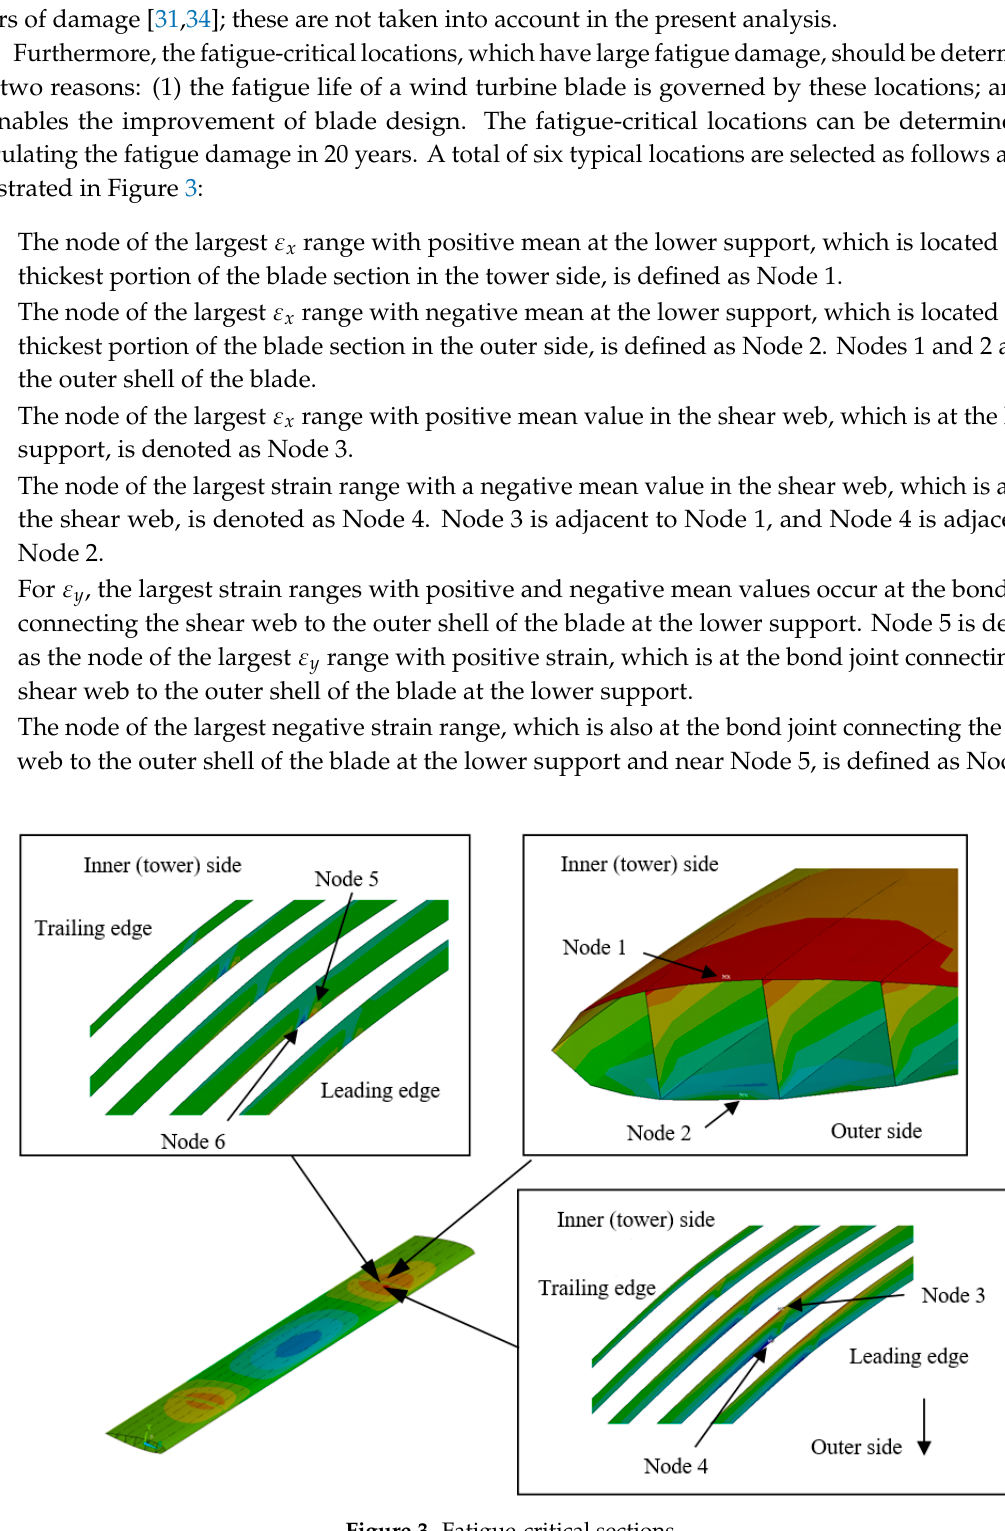
Figure 3. Fatigue-critical sections.